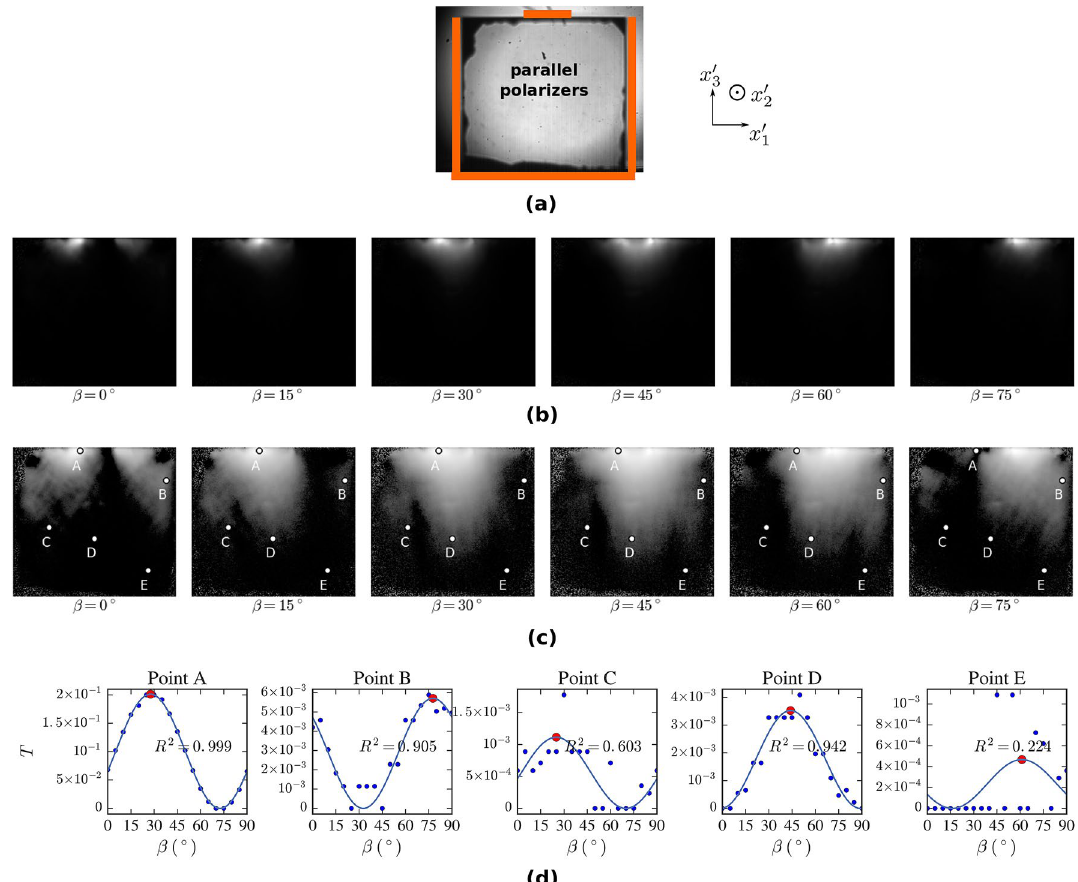
Figure 5. Camera image of the sample at zero bias and parallel polarizers illuminated with light at 1550 nm ( a ). Orange lines denote the positions of the electrodes. The sample is transparent except for several dark areas at the periphery, which are a sign of bad optical quality due to the surface finishing. Part ( b ) shows the Pockels x ′ 1 , x ′ 3 transmittance T of the biased sample (− 500 V on the stripe electrode, sample area only) at several x ′ 1 , x ′ 3 polarizer angles β in the range of 0°–90°. The log 10 T is shown in ( c ) including the positions of pixels A–E (cid:30) (cid:31) chosen for the demonstration of the analysis, in which case the [ β max , T max ] positions (large red circles) ( d ) (cid:31) (cid:30)